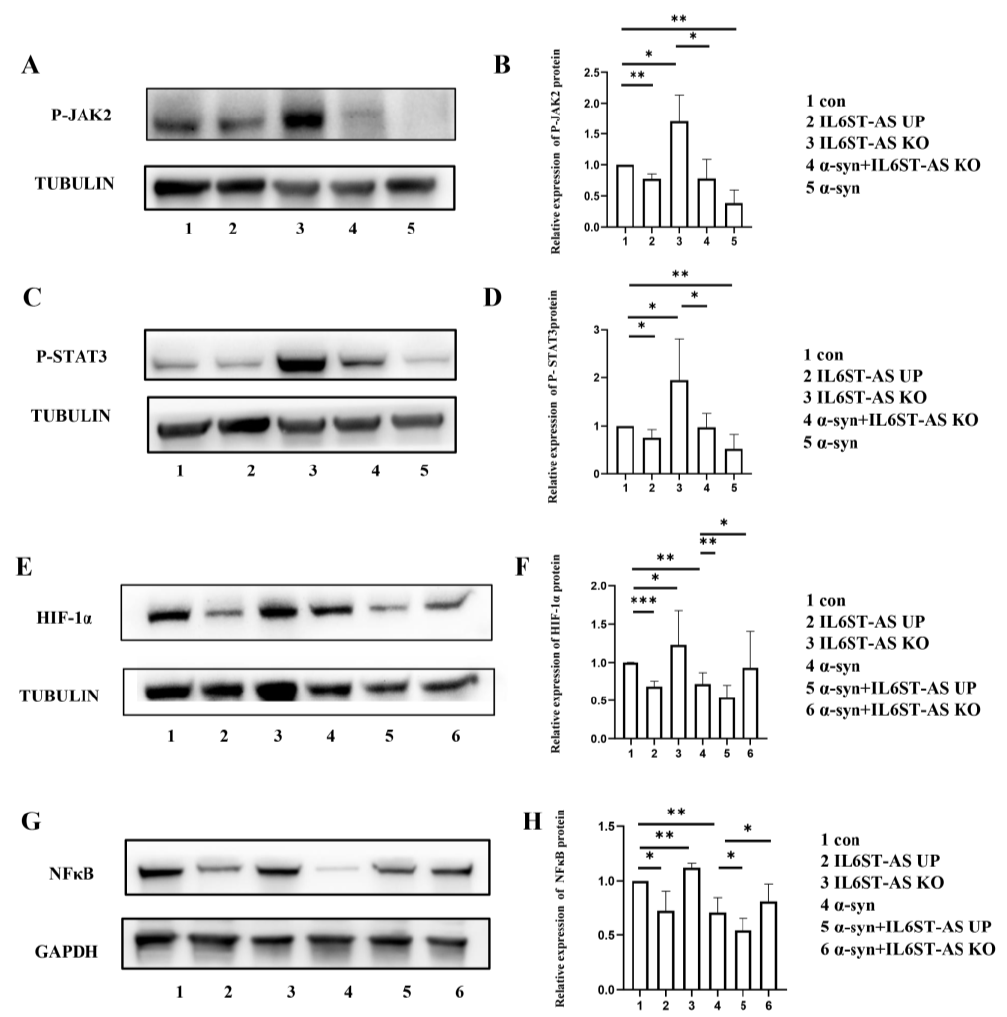
Figure 3. Over-expression of IL6ST-AS resulted in the inhibition of JAK2-STAT3 pathway and NF- κ B- related pathway. HMC3 cells were divided into five groups: control (con), IL6ST-AS UP, IL6ST-AS KO, α -synuclein-induced (25 µ mol/L) HMC3 cells ( α -syn), and α -syn + IL6ST-AS KO. ( A ) The expression of P-JAK2 was detected by Western blot in HMC3 cells. ( B ) Quantitative data of Western blots in ( A ). ( C ) The expression of P-STAT3 was detected by Western blot in HMC3 cells. ( D ) Quantitative data of Western blots in ( C ). HMC3 cells were divided into six groups: control (con), IL6ST-AS UP, IL6ST-AS KO, α -synuclein-induced (25 µ mol/L) HMC3 cells ( α -syn), α -syn + IL6ST-AS UP, and α -syn + IL6ST-AS KO. ( E ) The expression of HIF-1 α was detected by Western blot in HMC3 cells. ( F ) Quantitative data of Western blots in ( E ). ( G ) The expression of NF- κ B was detected by Western blot in HMC3 cells. ( H ) Quantitative data of Western blots in ( G ). Data = mean ± SD, * indicates p < 0.05, ** indicates p < 0.01, *** indicates p < 0.001. When cultured with IL6ST-AS -overexpressing HMC3 cells or α -synuclein-induced HMC3 cells (Figure 4A), the levels of p-STAT3 and HIF-1 α in SH-SY5Y cells decreased compared with those in the control SH-SY5Y cells. This change tendency of p-STAT3 and HIF-1 α was different from that in α -synuclein-induced SH-SY5Y cells (Figure 4B–G). This indicates that the IL6ST-AS -dependent JAK2-STAT3 pathway inhibition in HMC3 cells might be an important regulatory process modulating the expression of HIF-1 α in co- cultured SH-SY5Y cells. In particular, the decrease in HIF-1 α was reversed in SH-SY5Y cells co-cultured with IL6ST-AS KO HMC3 cells, regardless of whether they were stimulated with α -synuclein or